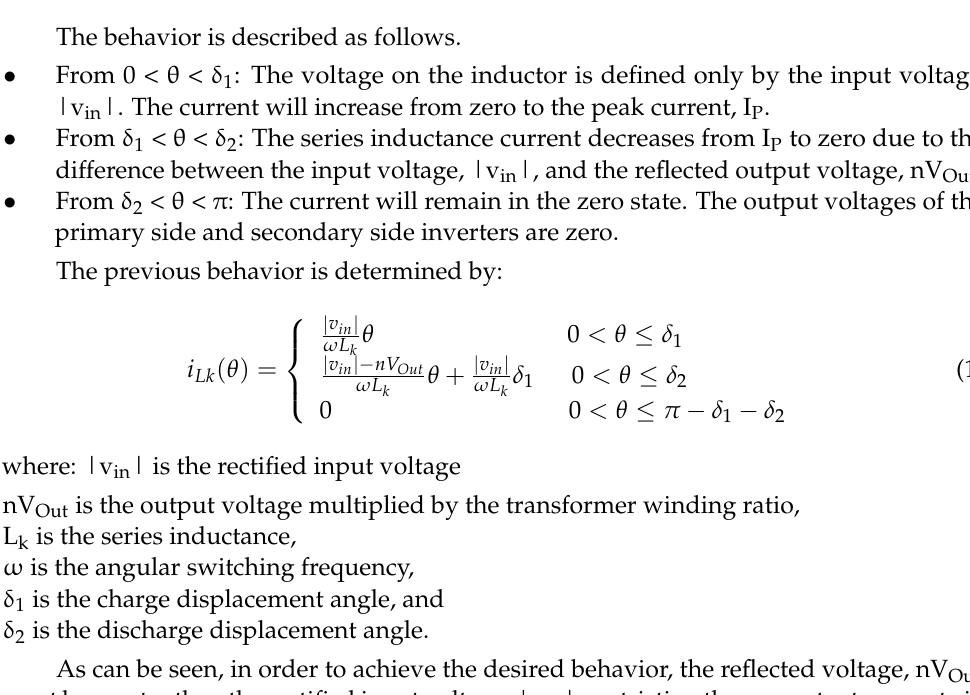
Figure 3. Boost QDCM waveforms. From top to bottom, series inductance current, primary-side inverter output voltage, reflected secondary-side inverter output voltage, and switch activation signals with their respective negated complementary pulses.